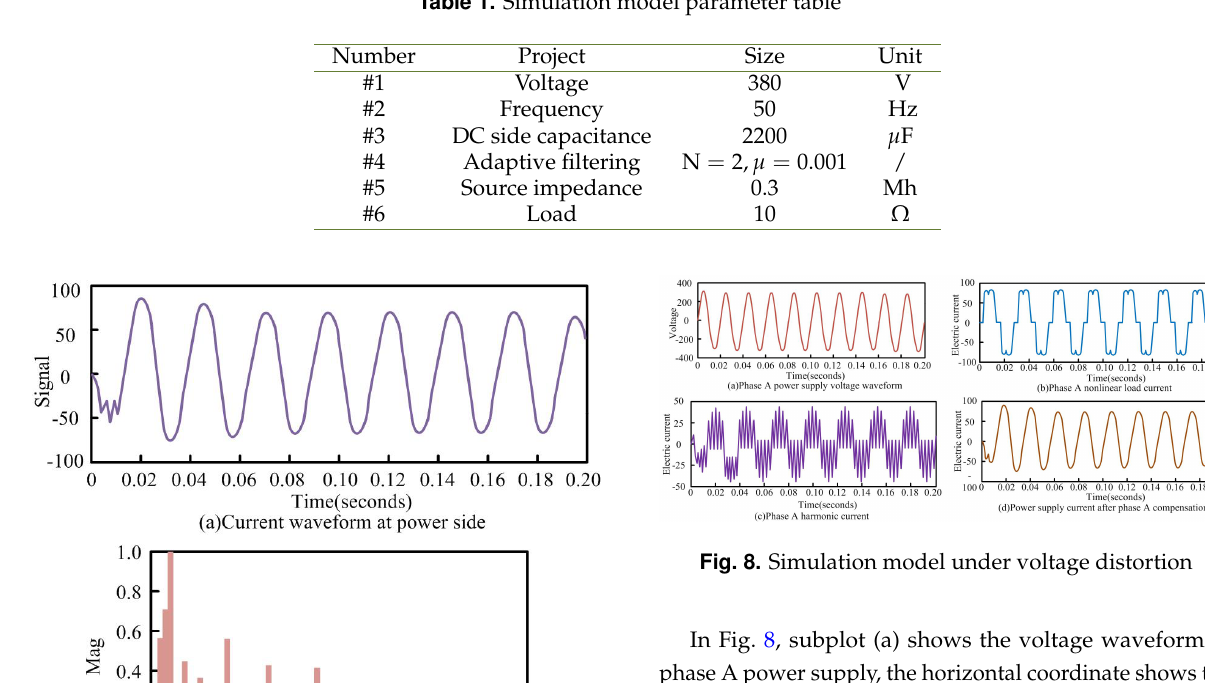
nate indicates the voltage in V; subplot (b) indicates the nonlinear load current of phase A power supply, subplot (c) indicates the harmonic current of phase A power supply, and subplot (d) indicates the current of phase A power supply after compensation; subplots (b), (c), Fig. 5 shows